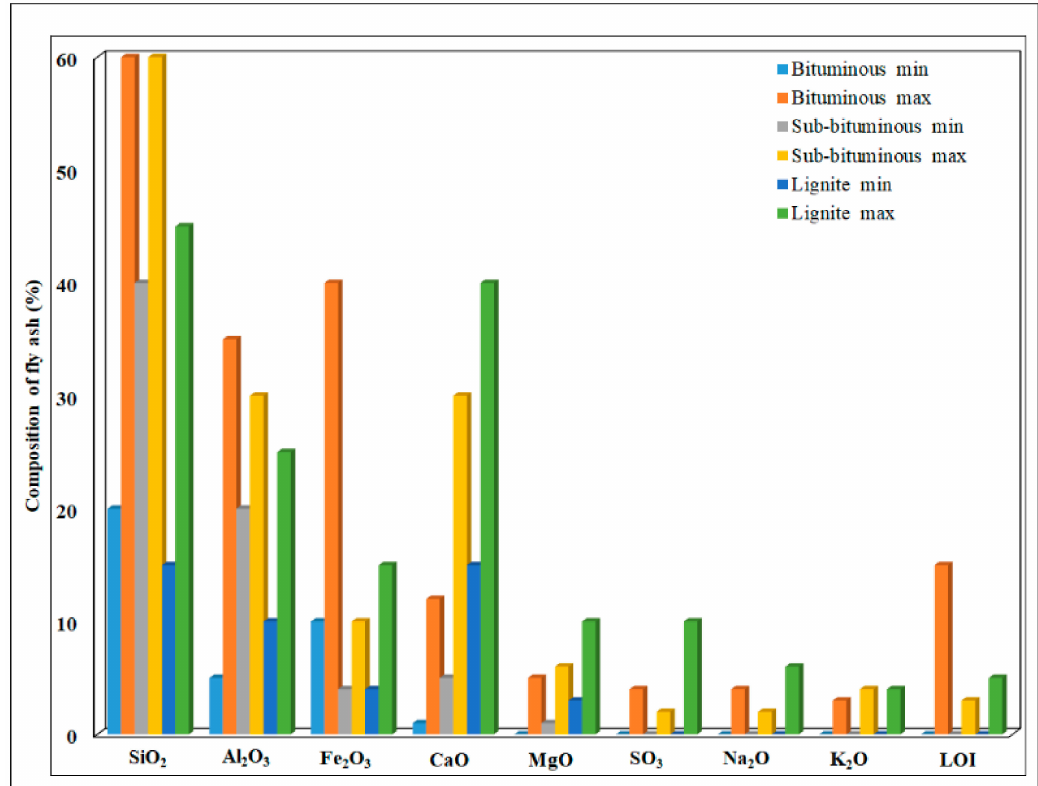
Figure 4. Di ff erent coal fly ash